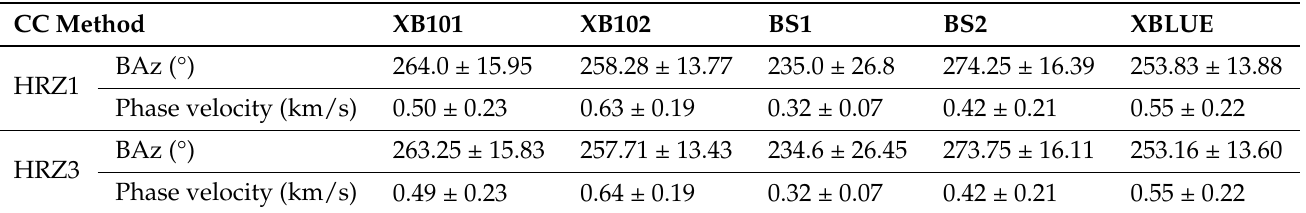
Table 4. BAz estimates in °and phase velocity estimates in km/s for all possible combinations of five rotational sensors and two seismometers. Mean values and standard deviation are calculated for all time windows with CC coefficients of > 0.65 for phase velocity and BAz. The real BAz is